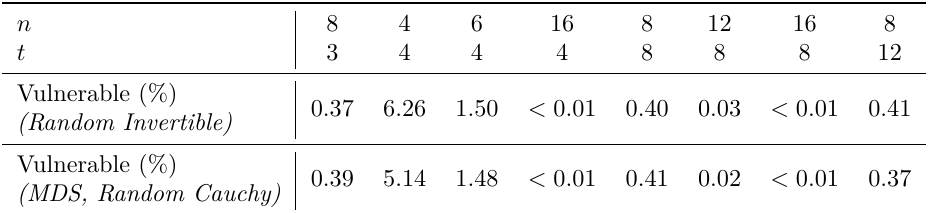
Table 2: Percentage of vulnerable matrices for Algorithm 1 and orders t , when considering binary fields F 2 n